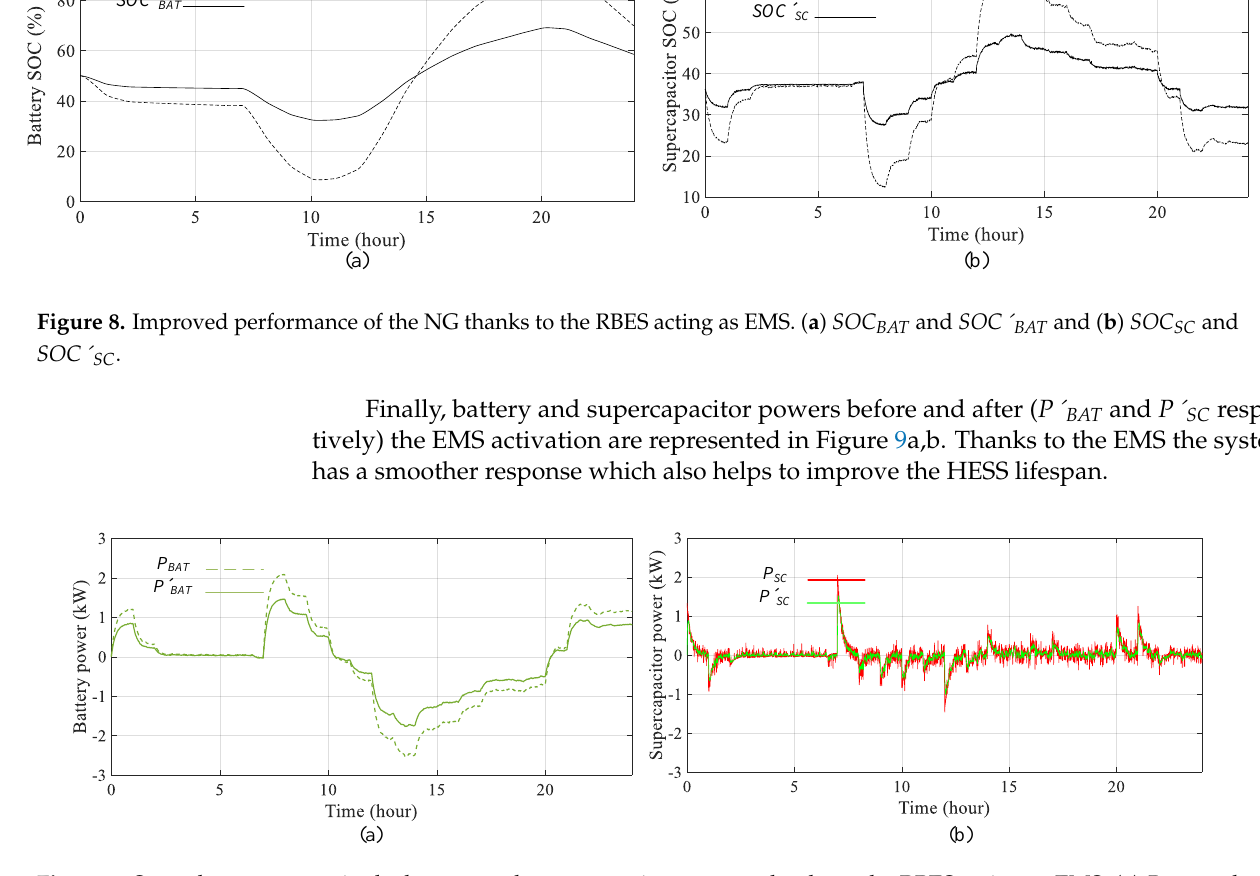
Figure 9. Smoother responses in the battery and supercapacitor powers thanks to the RBES acting as EMS. ( a ) P BAT and P ´ BAT and ( b ) P SC and P ´ SC